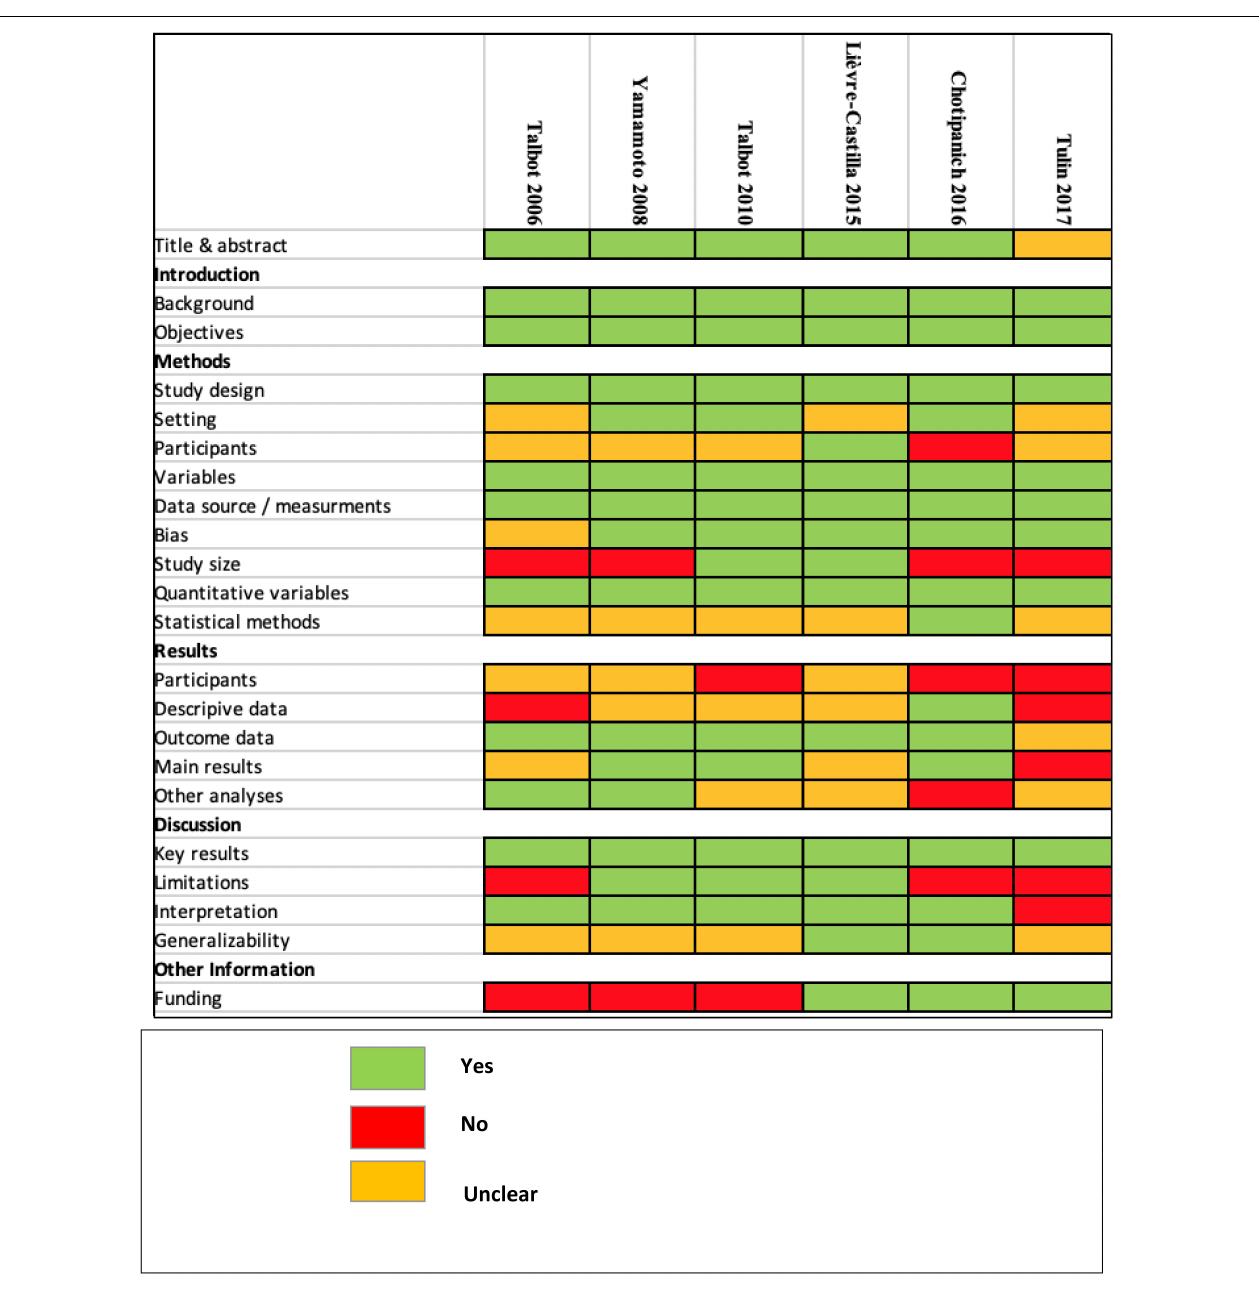
FIGURE 2 | STROBE quality